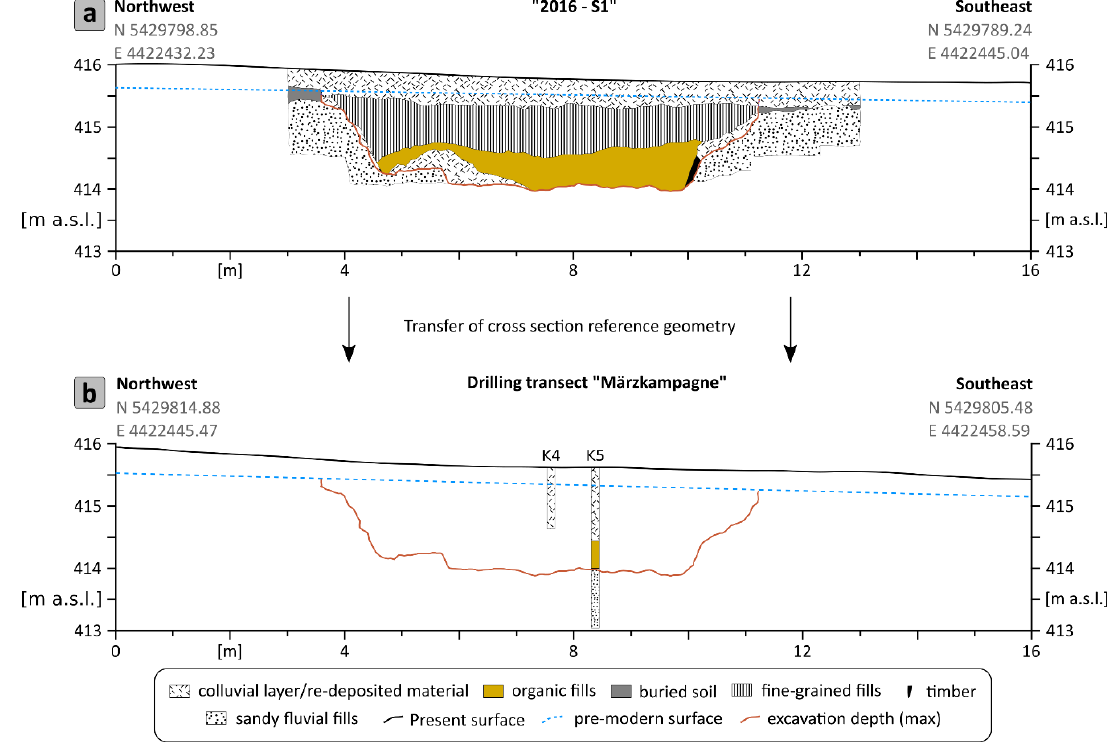
Figure 9: Exemplary transfer of the cross- section reference geometry “2016/S1” to the vibra -coring Figure 9. Exemplary transfer of the cross-section reference geometry “2016 / S1” to the vibra-coring transect “Märzkampagne”. transect